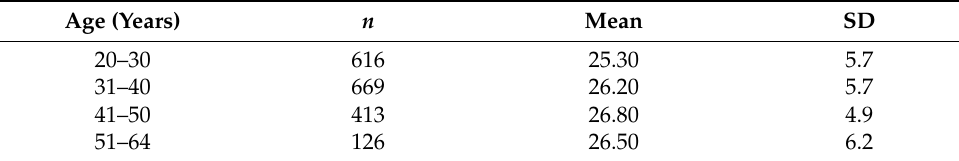
Table 3. Mean total facilitator score for nurses’ age categories.